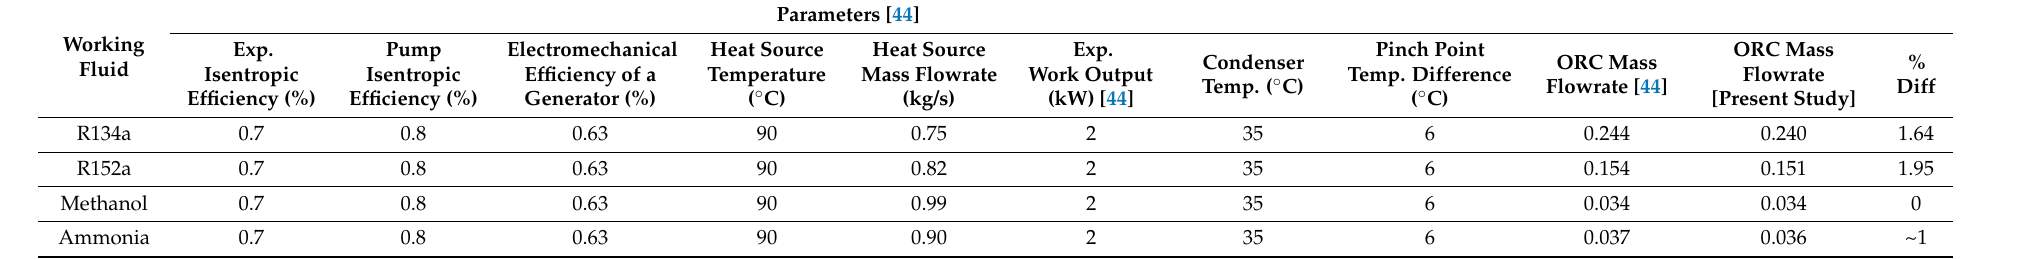
Table 4. Validation of the present simulation with Ref. [49], considering the conditions of Ref. [49] for